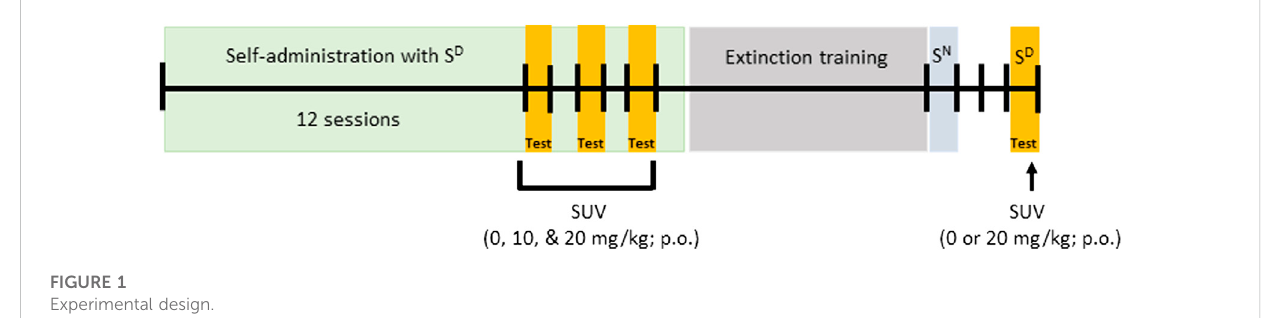
FIGURE 1 Experimental